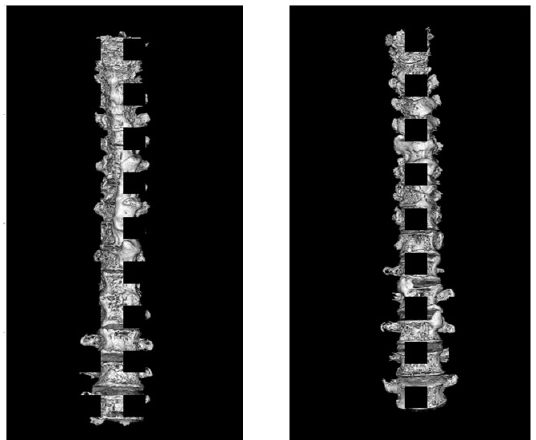
Figure 2. Images of converted augmentation. Scaling, rotation, horizontal flip, top/down and right/left migration, and GridMask were performed.